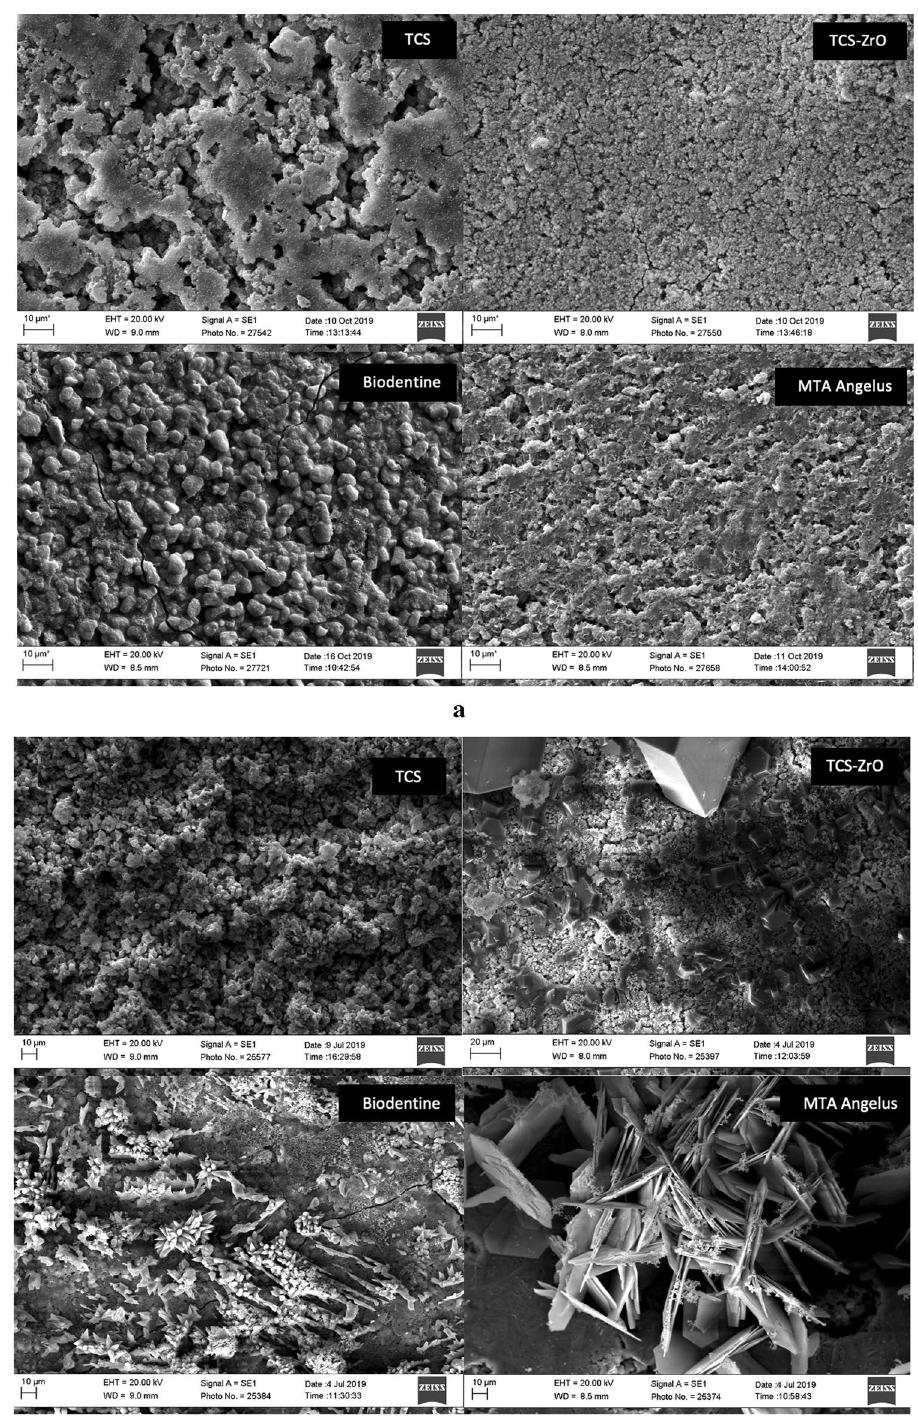
Figure 4. Secondary electron scanning electron micrographs showing surface microstructure of all test materials in contact with ( a ) water, ( b ) HBSS, ( c ) HBSS + FCS. For all solutions various surface deposits were observed with generalized discreet crystals observed over the surface of all materials in water, calcium hydroxide crystals (hexagonal) and calcium phosphate (spheres) in HBSS and discrete round crystals of calcium carbonate for the HBSS +